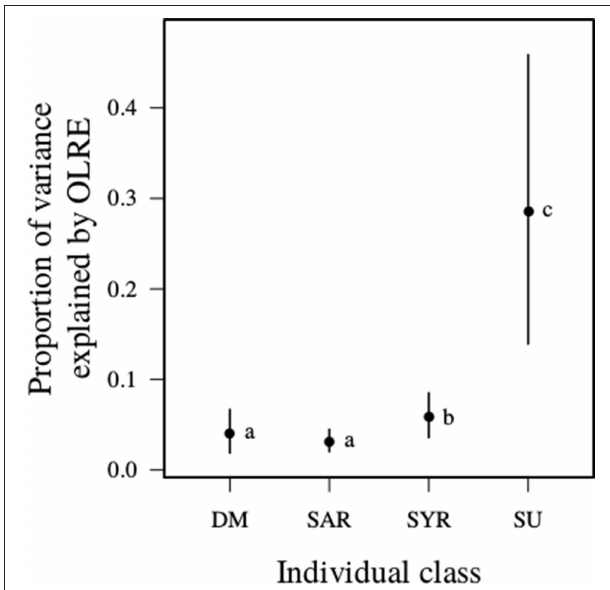
FIGURE 4 | Proportion of variance explained by observation level random effect (OLRE) to total variance (i.e., sum of fixed effect variance, random effect variance, and distribution specific variance) in daily provisioning rate explained by a Poisson distribution ( Table 2 ). Acronyms and meteorological measures are as for Figure 2 . The different letters inset indicate where the 95% CI of the difference between the categories did not include zero. Plot shows predicted means and 95% CI.